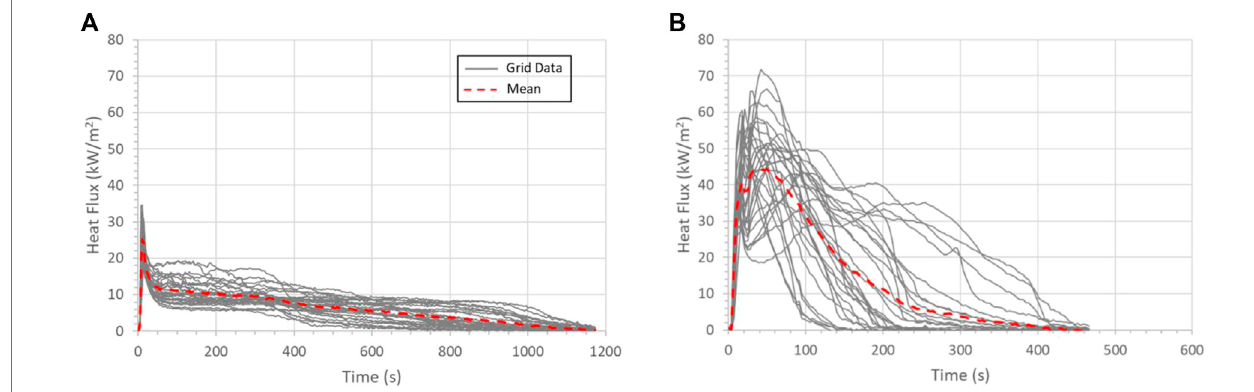
FIGURE4| Samplegridheat fl uxdatawithtimefor (A) FF6withnowindand (B) FF14with2.0 m/swind.Testshadapilemassof3.0 gcontaining fi rebrandswitha diameter 4.75 mm, length 50 mm, and 0% MC.